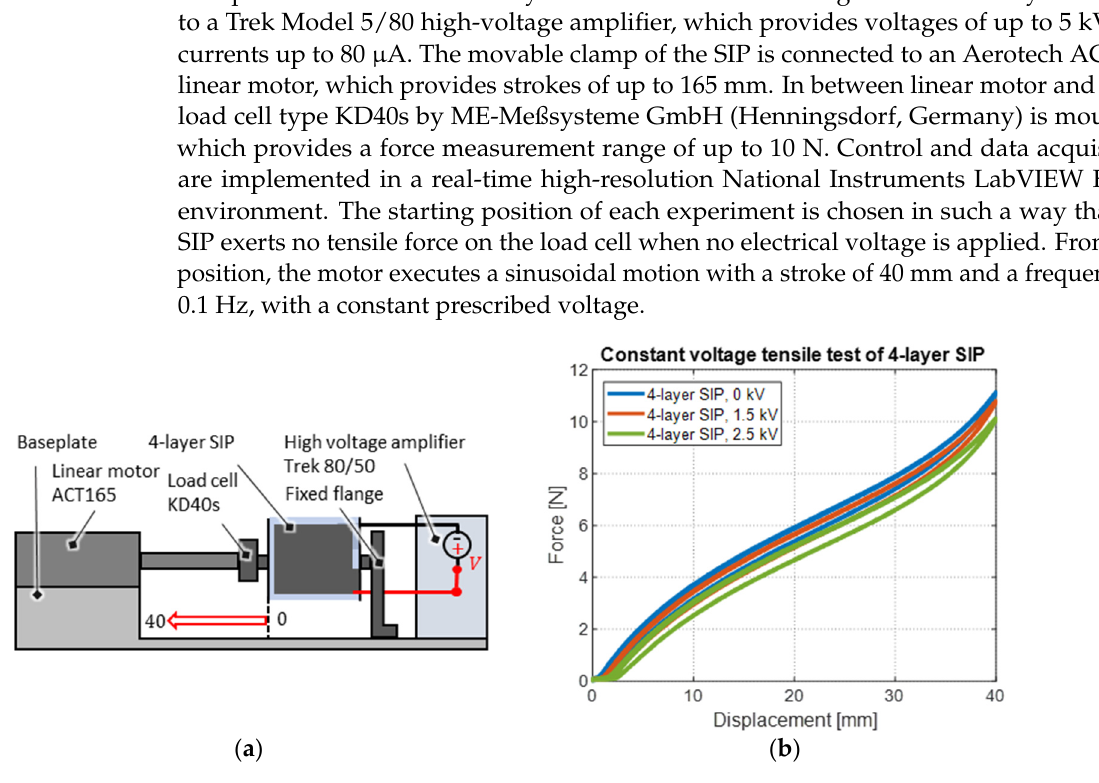
Figure 10. ( a ) Schematic illustration of the tensile test setup for SIP characterization with different voltages applied and ( b ) corresponding measurement results in a force-displacement diagram.